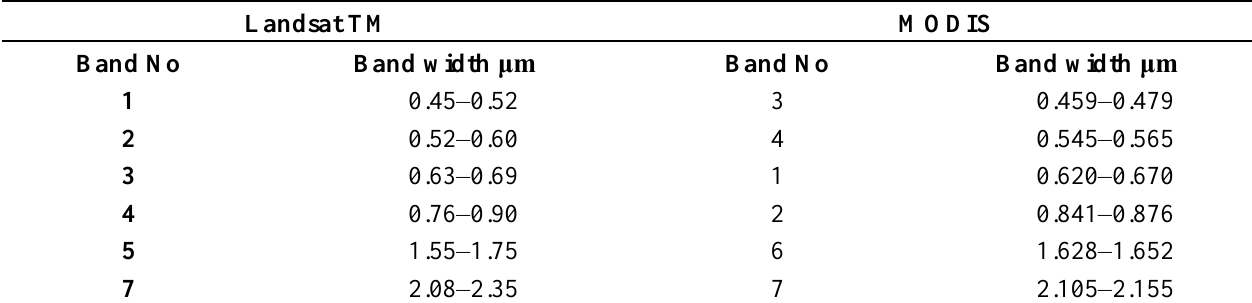
Table 2. Landsat TM bands and corresponding MODIS bands and their band width.